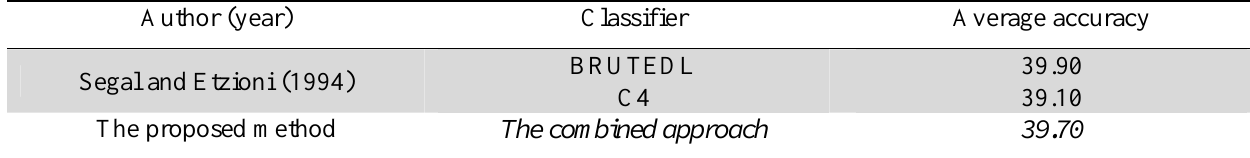
The proposed model in comparison with other classifiers in “Primary Tumor”